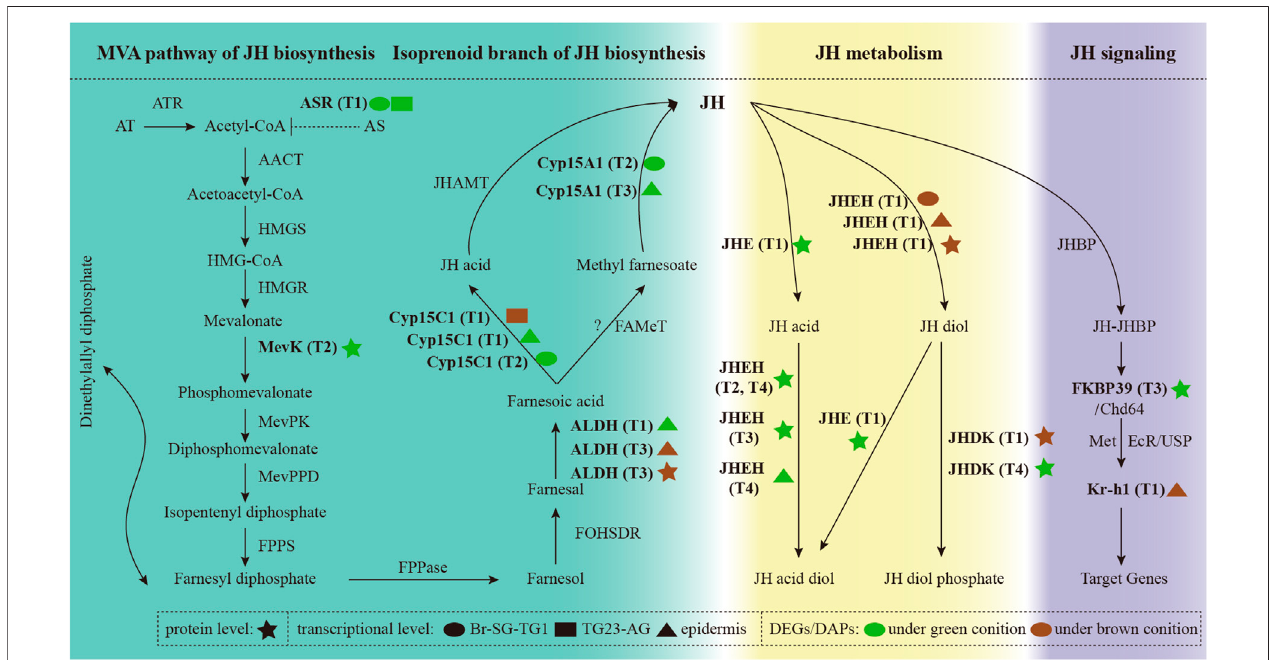
FIGURE 5 | The expression pro fi les of genes involved in the biosynthesis, metabolism, and signaling of juvenile hormone. Full information of genes, tissues and periods refers to Supplementary Table S5 and Figure 1